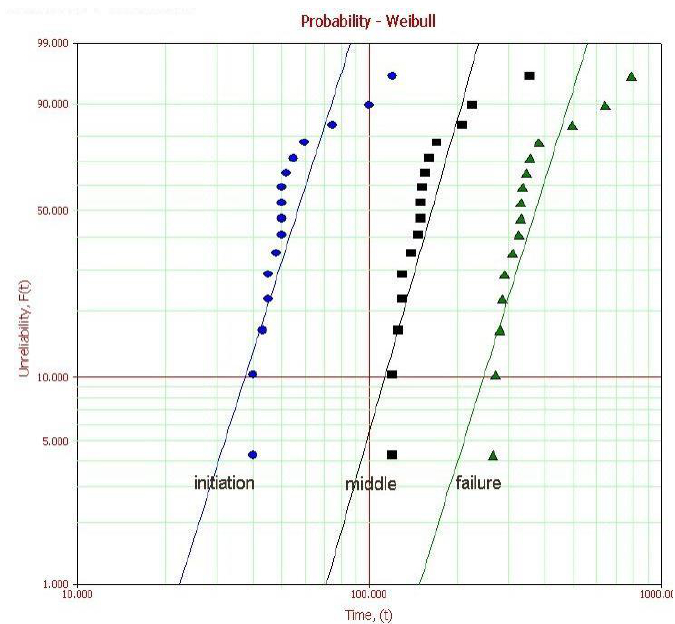
Figure 11. Time to failure of the Weibull distribution of tree model 3 (divided by three progress: initiation, middle, failure).